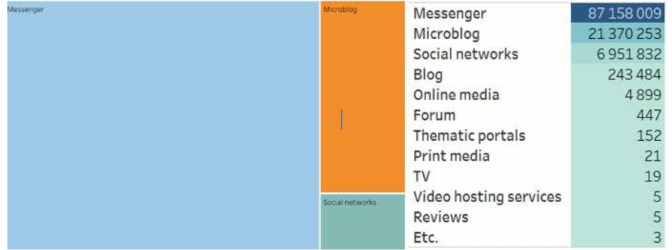
Figure 1. Digital platforms of regional actors.